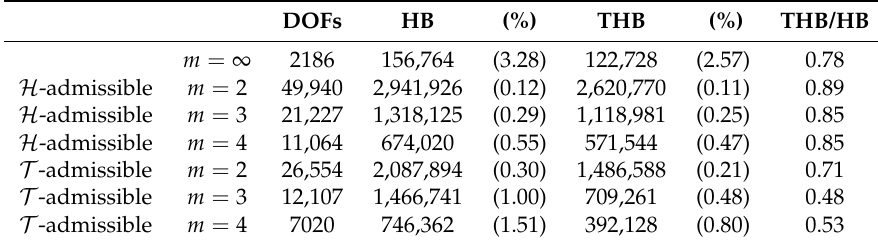
Table 2. Number of nonzeros of the stiffness matrix for p = ( 3,3 ) .